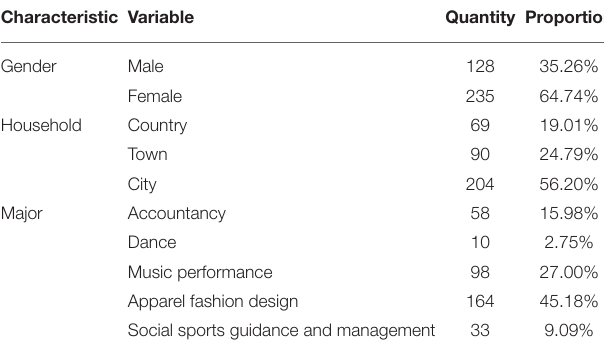
TABLE 1 | The basic information of